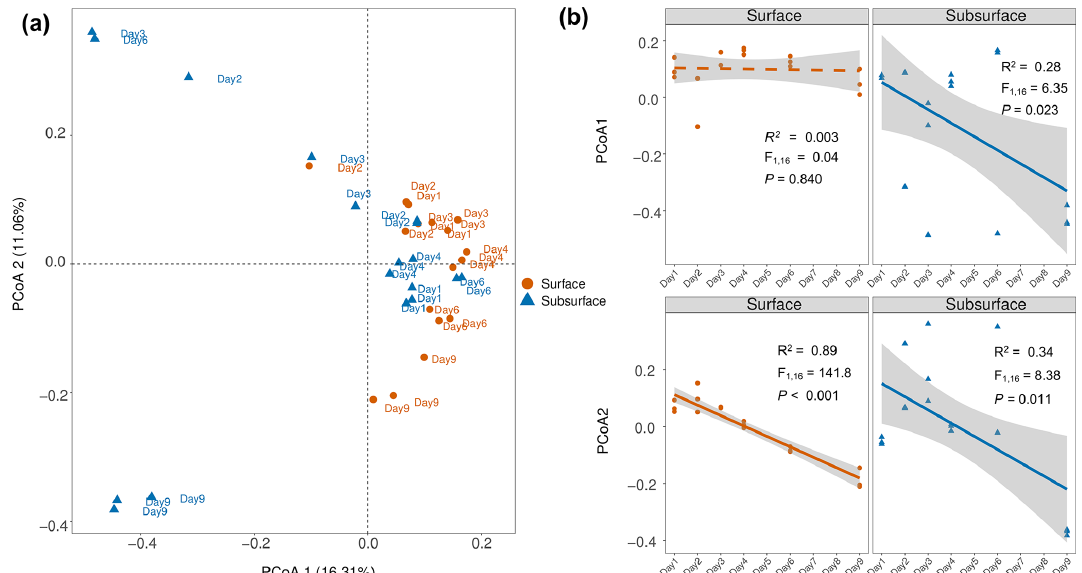
Figure 5. Principal coordinate analysis (PCoA) of microbial communities in the surface and subsurface snow. (a) Bray–Curtis distance-based PCoA ordination plot. The microbial community structures of the surface and subsurface snows are significantly different (PERMANOVA, p < 0 . 001). (b) Pairwise regression analysis between PCoA scores and sampling time. The solid and dashed lines indicate significant and insignificant changes (based on linear regression), respectively. The PCoA1 scores for the bacterial community in the surface layer exhibit no significant correlation with time, while the PCoA2 scores significantly correlated with time. The PCoA1 and PCoA2 are both significantly correlated with time in the subsurface layer. Grey shading indicates the 95% confidence interval of regression.